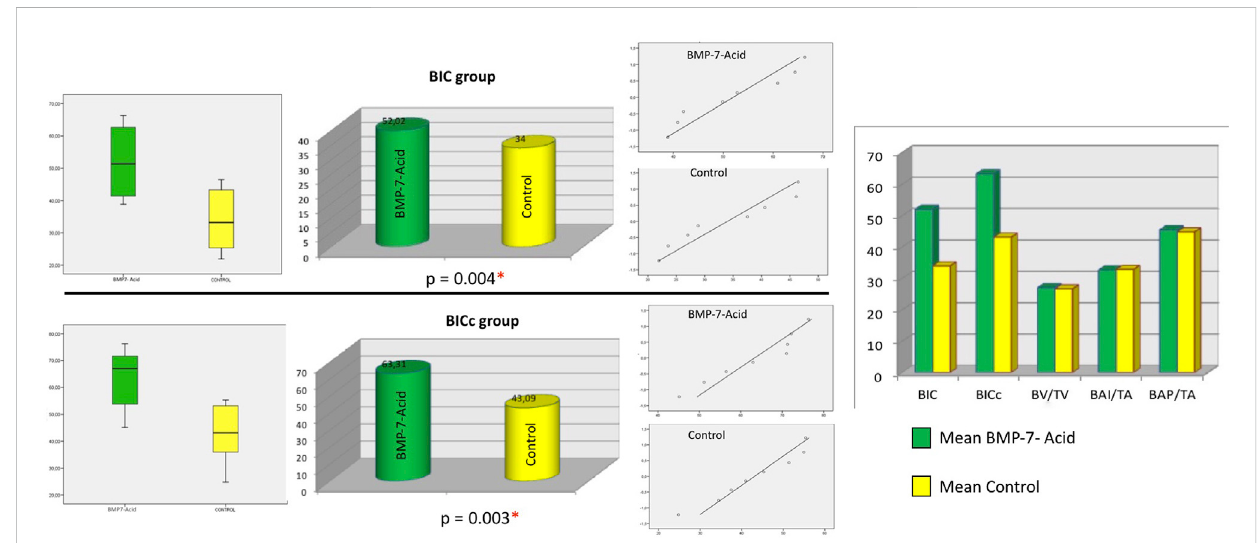
FIGURE 2 ForbothBICandBICc, theboxplotshowsthat themeanvalueoftheBMP7-acidgroup(testgroup) washigher thanthatofthecontrol group.Inthe Q-Qplots,thepointsarewithinthecon fi denceintervalandarerandomlydistributedonbothsidesoftheaxis,indicatingthatthedistributionisnormalfor each group and variable. The bar chart shows the means of the compared groups (statistically signi fi cant for the variables BIC and BICc). * Statistical signi fi